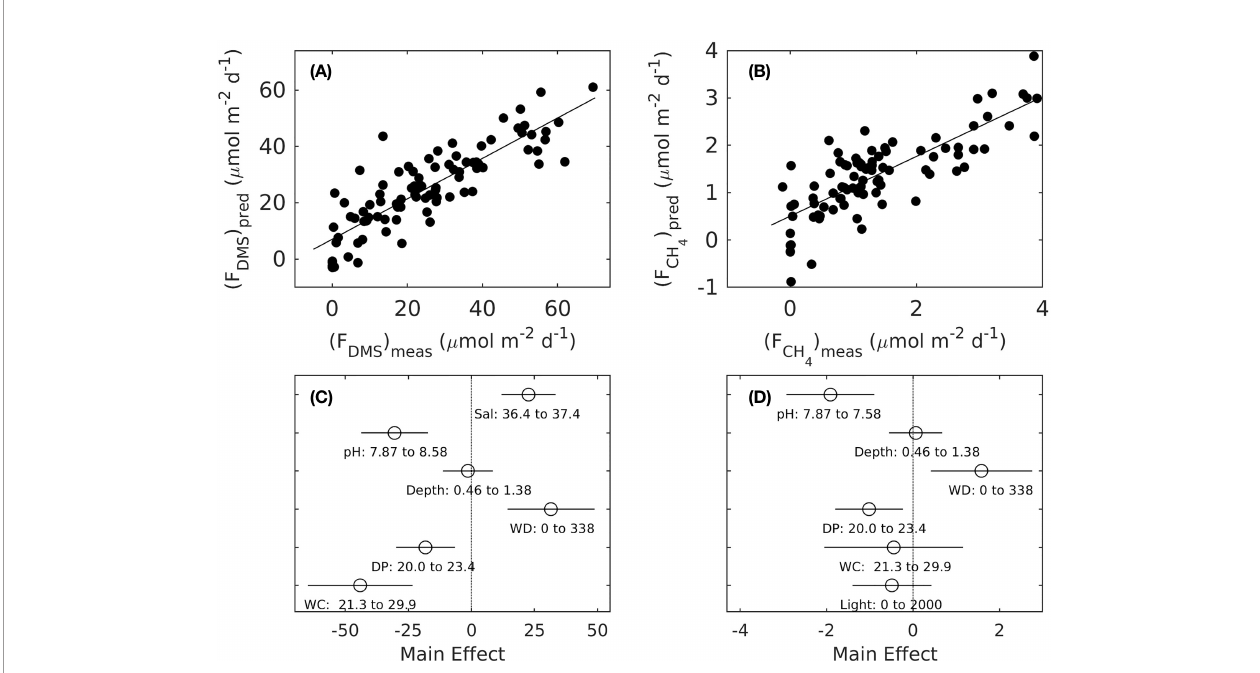
FIGURE 3 | Linear fi ts through in situ and predicted sea-to-air DMS ( A , R 2 = 0.717) and CH 4 ( B , R 2 = 0.631) fl uxes by the stepwise Multiple Linear Regression (MLR) model with the lowest Akaike Information Criterion (AIC) with six main variables, and resulting main effect sizes of salinity, pH, depth, wind direction (WD), Dewpoint (DP) and Wind Chill (WC) for DMS fl uxes (C) and of pH, depth, WD, DP and WC and light for CH 4 fl uxes (D) (compare to Table 1